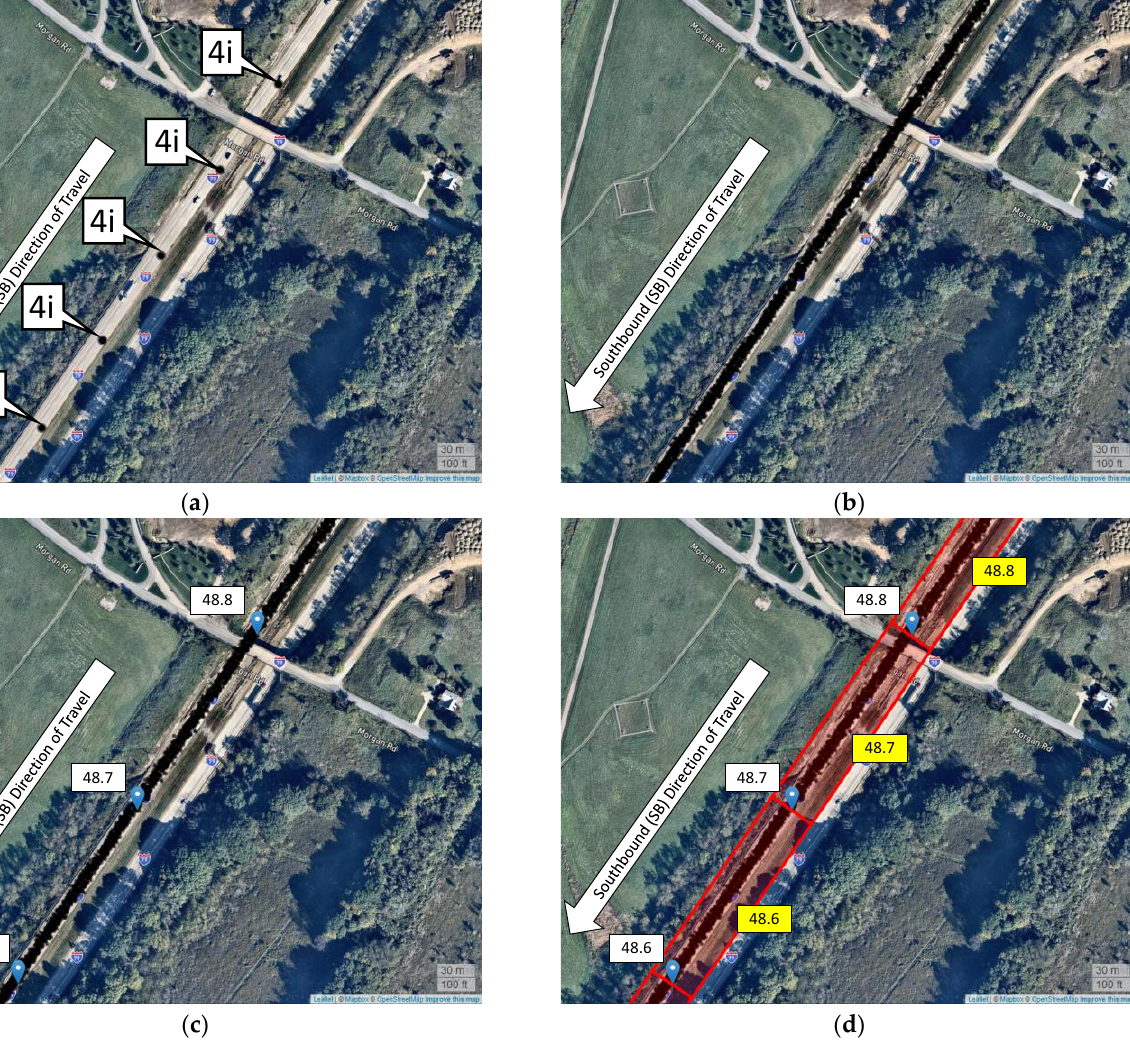
Figure 4. Geospatial joining of connected vehicle trajectories to roadway mile markers. ( a ) Trajectory data every 3 s from one CV. ( b ) All CV trajectories. ( c ) Overlaying interstate mile markers. ( d ) Geospatial joining of CV trajectory points to interstate mile marker polygons. Callout 4i shows the datapoints from one CV.